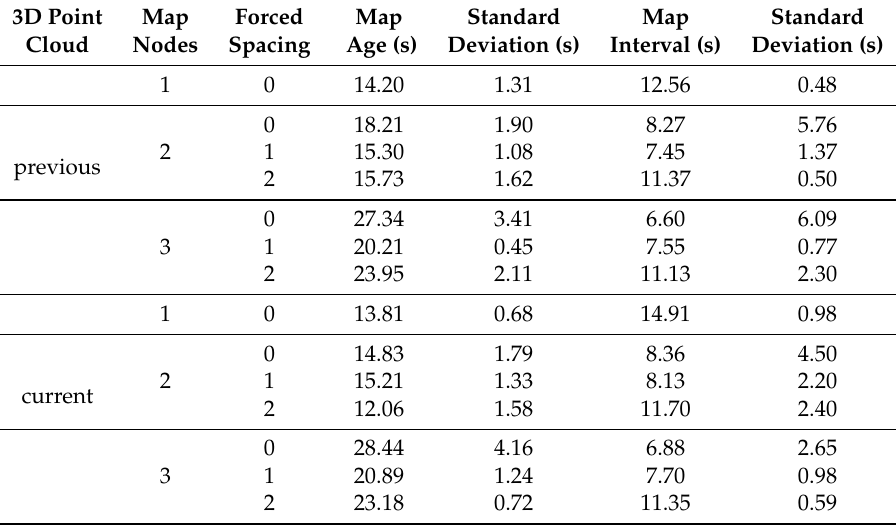
Table 1. Comparison between different multithreaded